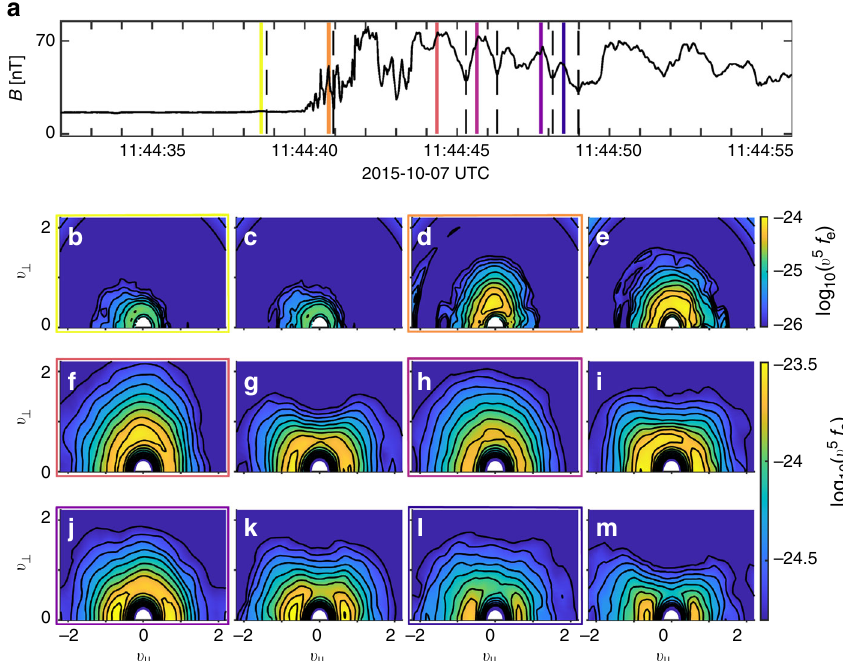
Fig. 7 Distributions along the bow shock crossing. a Magnetic fi eld observed by MMS4 along the bow shock crossing. b – m Electron distribution functions at the peaks and the corresponding valleys of magnetic fl uctuations along the bow shock crossing are plotted. The distributions with the colored borders are the distributions taken at the magnetic peaks at the times denoted by the colored lines in a . The adjacent distributions are taken at the associated valleys denoted by the adjacent dashed lines in a